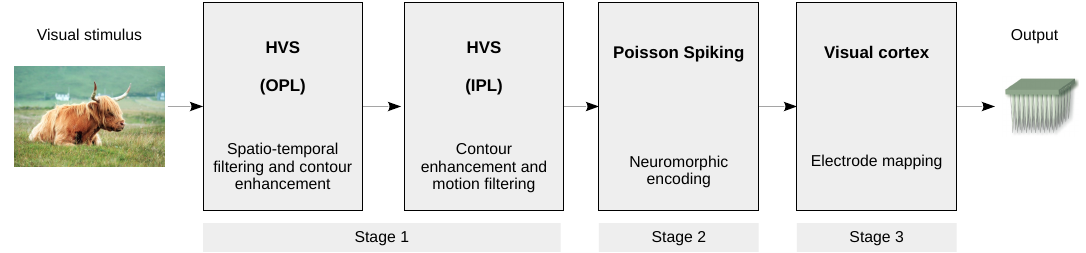
Figure 3. Functional processing blocks of the Human Visual System Poisson (HVSP) model. This figure is a derivative of “Highland cattle, Skye Island” by Qu1m, used under CC BY, and Webvision